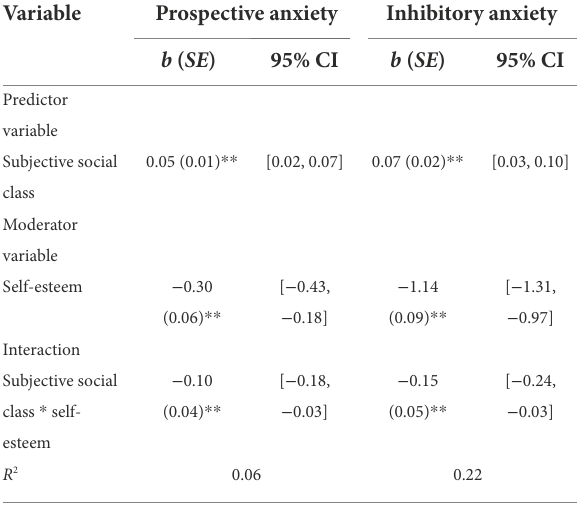
TABLE 3 Self-esteem as a